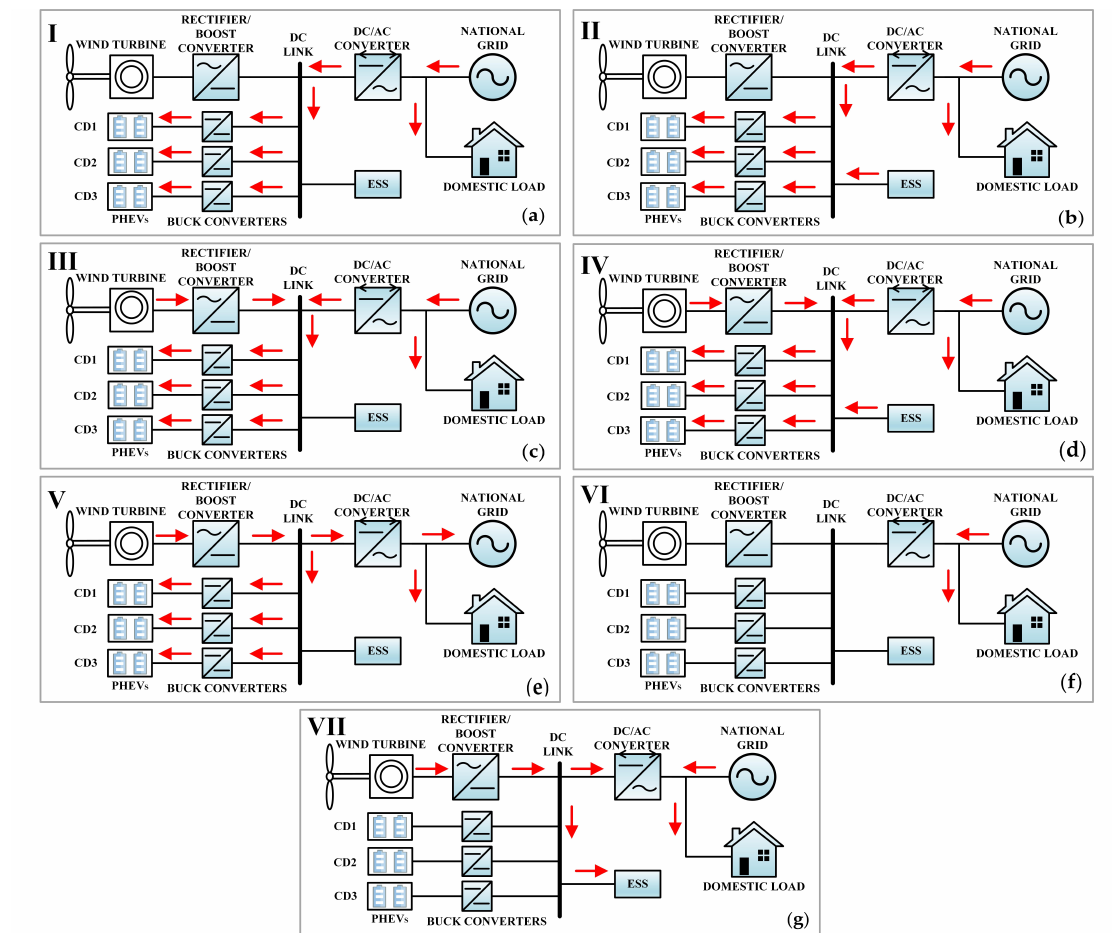
Figure 10. Power flow in proposed charging stations (CS) in ( a ) state I, ( b ) state II, ( c ) state III, ( d ) state IV, ( e ) state V, ( f ) state VI, and ( g ) state